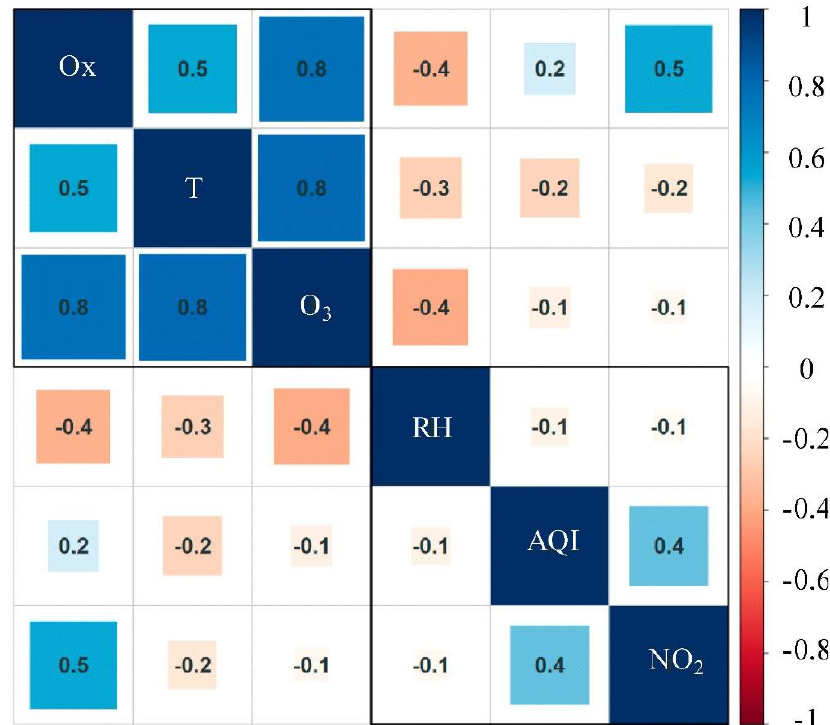
Figure 5. Correlations between pollutants and meteorological elements.